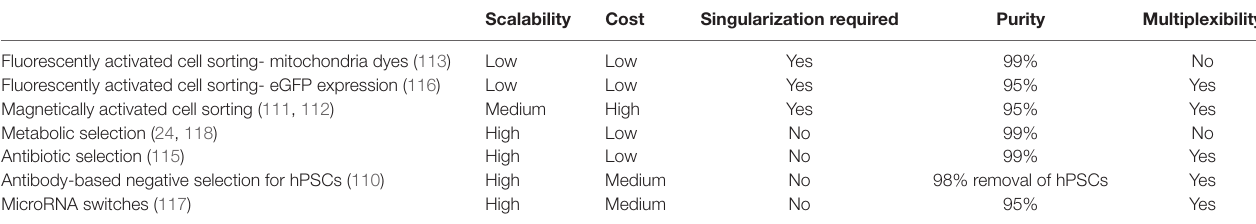
TAbLe 4 | Purification methods for large-scale production of human pluripotent stem cell (hPSC)-derived